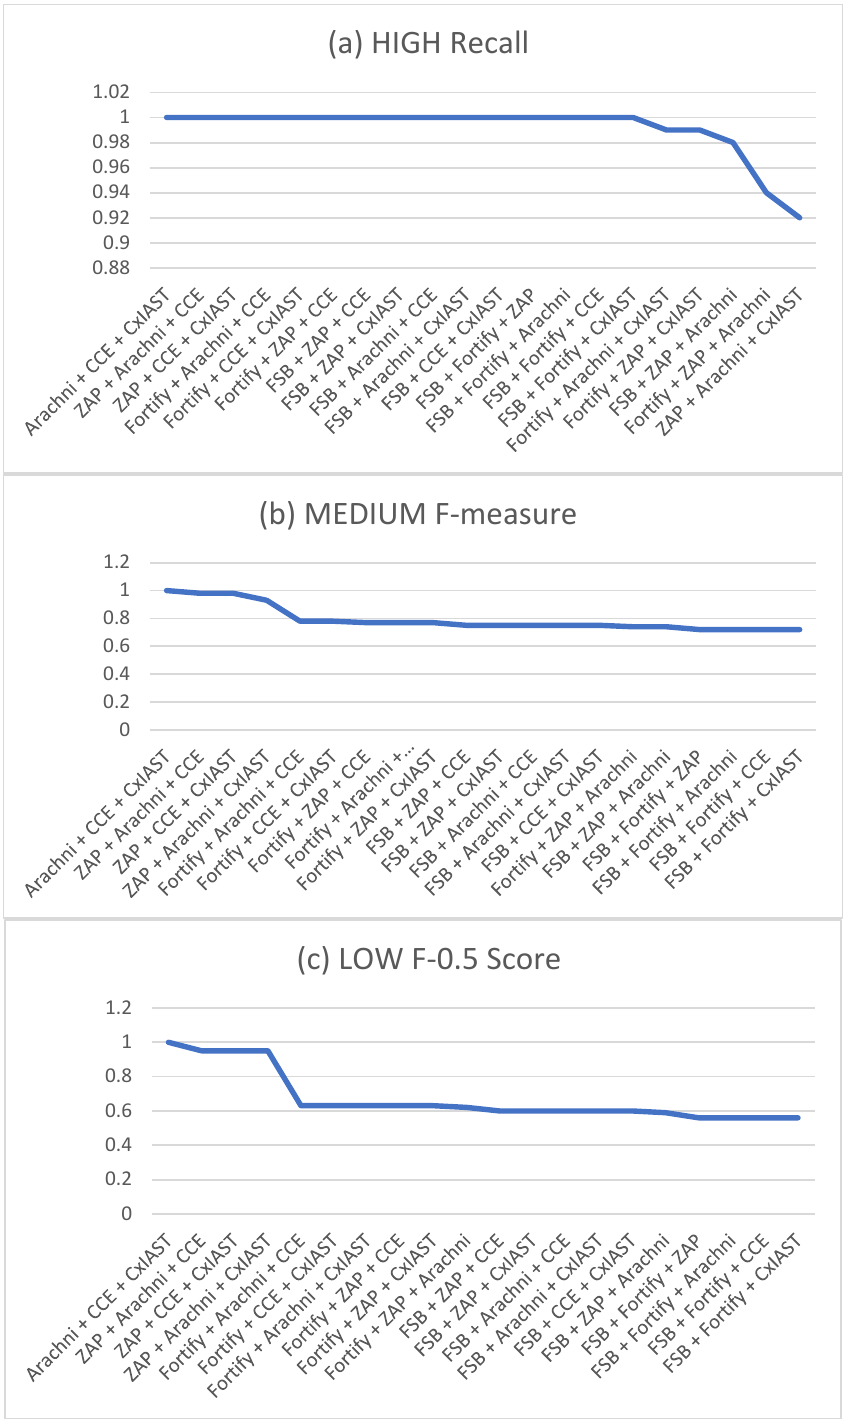
Figure 8. Rankings for ( a ) high, ( b ) medium, and ( c ) low criticality levels for 3-tools combinations.